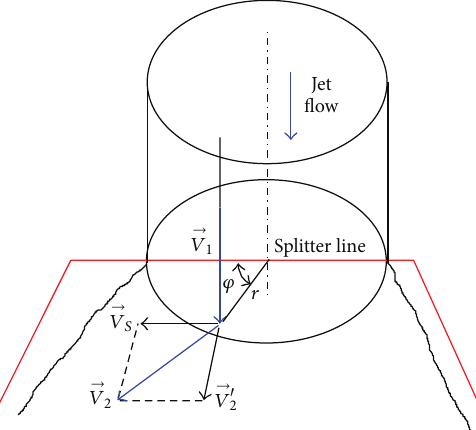
Figure 2: Sketch of surface flow spreading